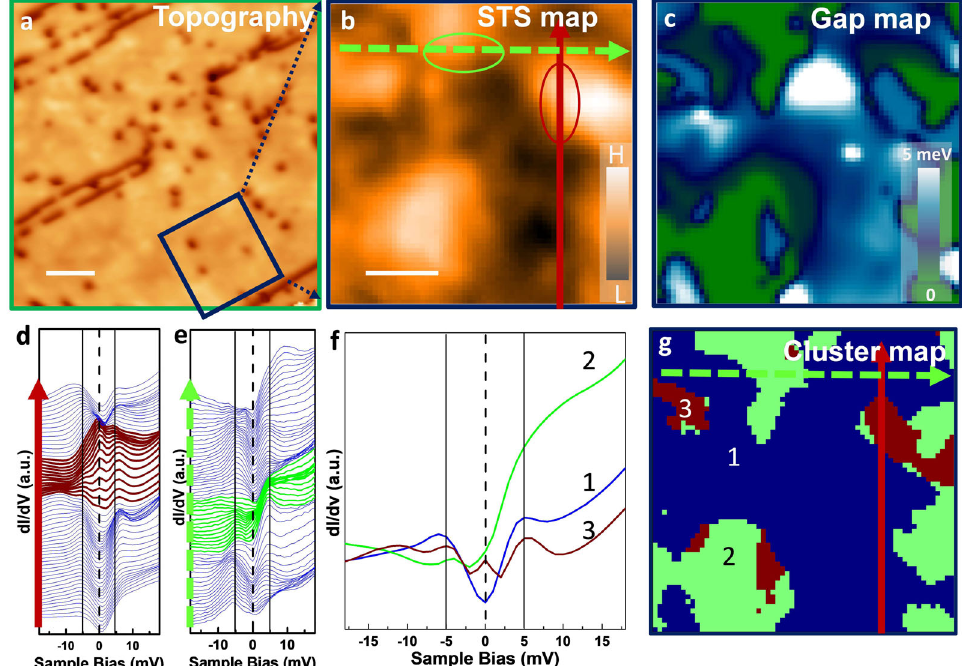
Fig. 2 Electronic inhomogeneity on the surface of Ba(Fe 0.96 Ni 0.04 ) 2 As 2 . a The STM topography image of Ni-122 from the green box in Fig. 1a, V Bias = − 20 mV and I t = 100 pA, the scale bar represents 6 nm. b STS map at Fermi level (0 meV) and c superconducting gap map from the same area (blue box in ( a )), the scale bar represents 3 nm. d , e The line STS spectra along the brown and green arrows in ( b ). Brown and green circles in ( b ) and spectra in ( d ) and ( e ) outline the non-SC areas. f Three K-means principal responses and g cluster map which shows the spatial distribution of each type of spectra from the same area as ( b